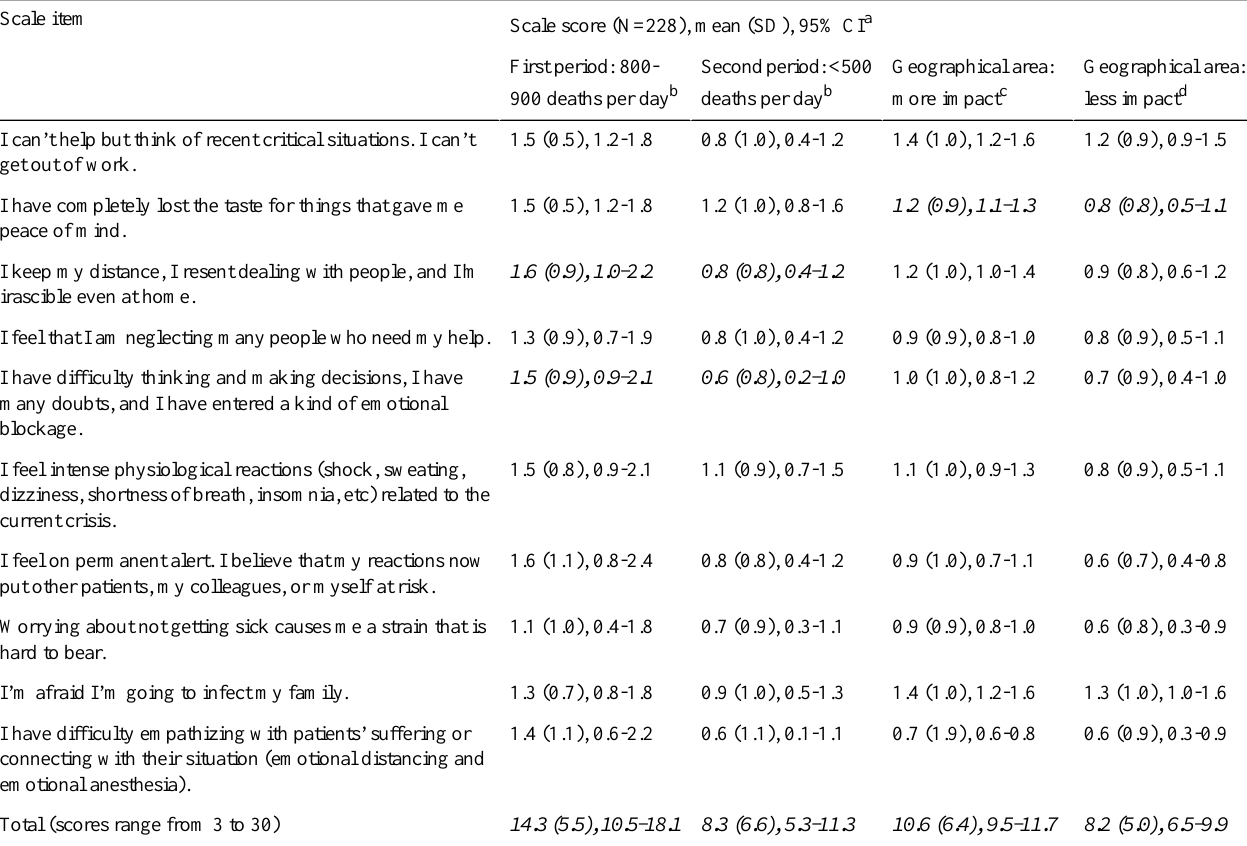
Table 3. Acute stress scale used among professionals caring for patients with COVID-19 over two periods and two geographical